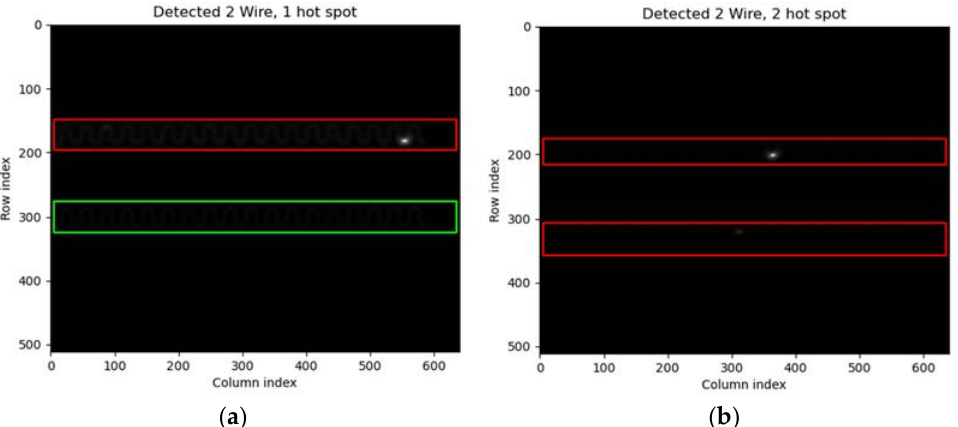
Figure 20. Hot spots detection on meander-shaped wires: ( a ) two wires with one hot spot ( b ) two wires with two hot spots.